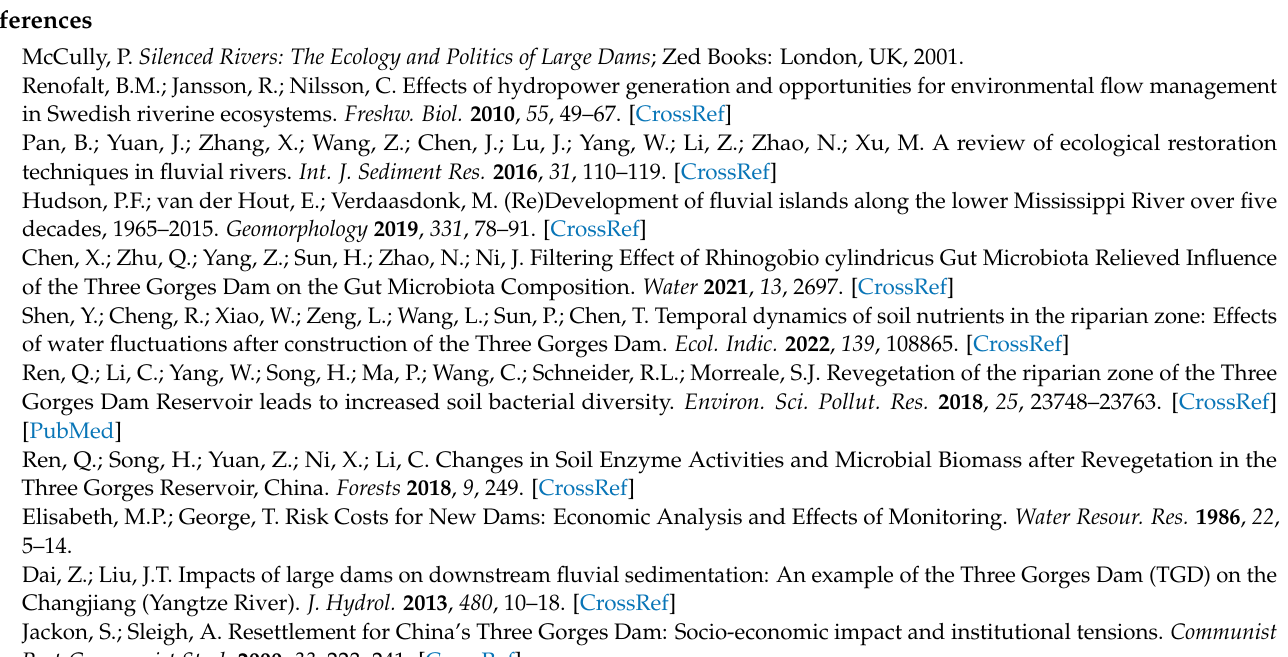
Notes: The figures in the parentheses are standard errors; *** denotes significance at the 1% level; ** denotes significance at the 5% level; * denotes significance at the 10% level; The dummy variables ‘Province’ are provincial fixed